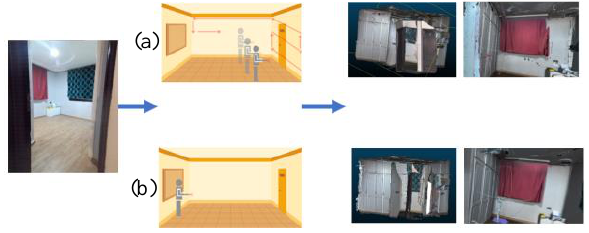
Figure 13. Results of acquisition two adjacent rooms by using single level (a) and wall by wall scanning (b).